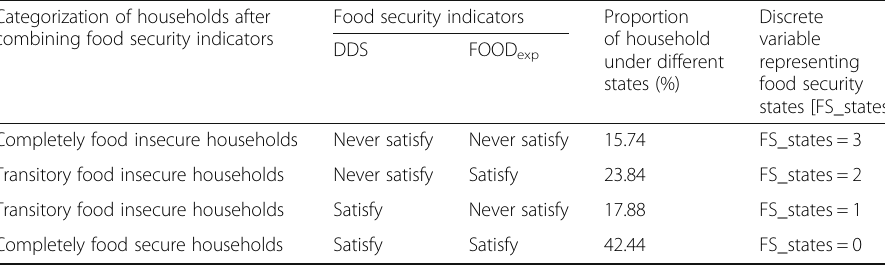
Food security indicators Proportion